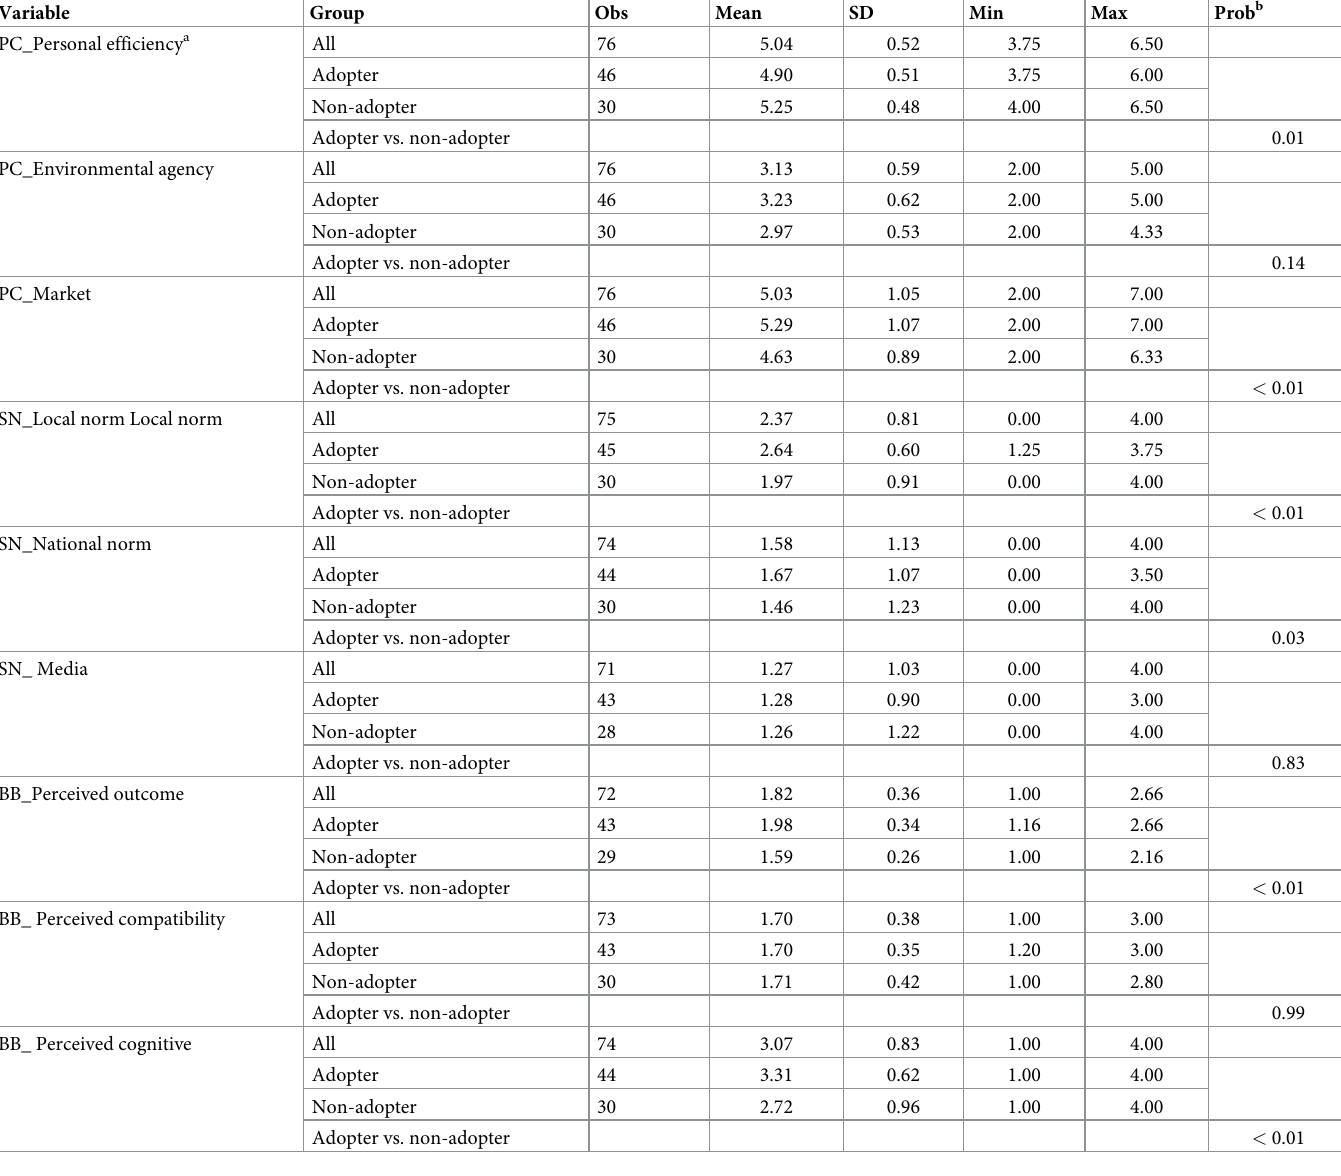
Table 4. Distribution of adopters and non-adopters by behavioral